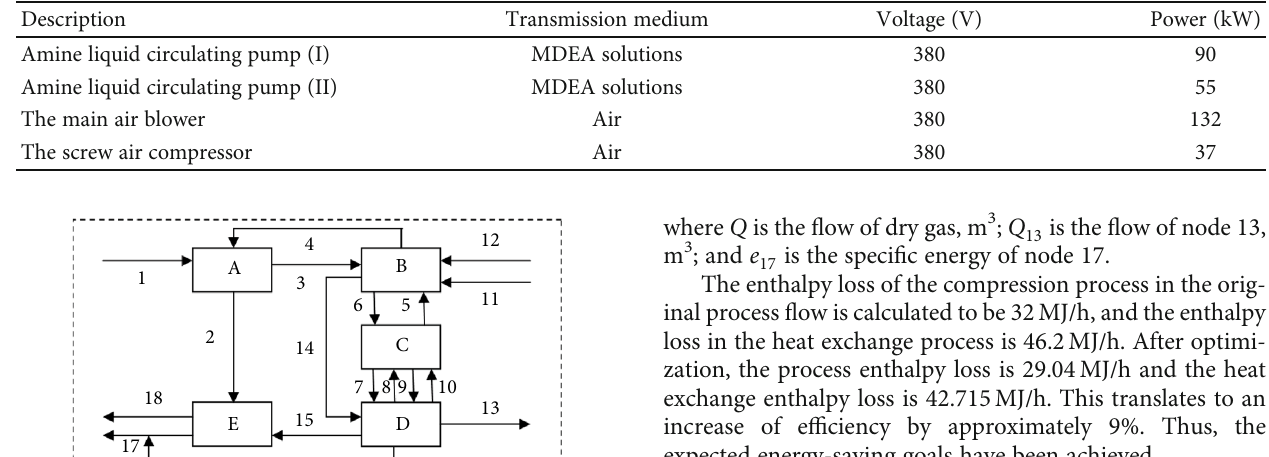
Table 4: Energy consumption (power consumption) details of the circulating pump and the